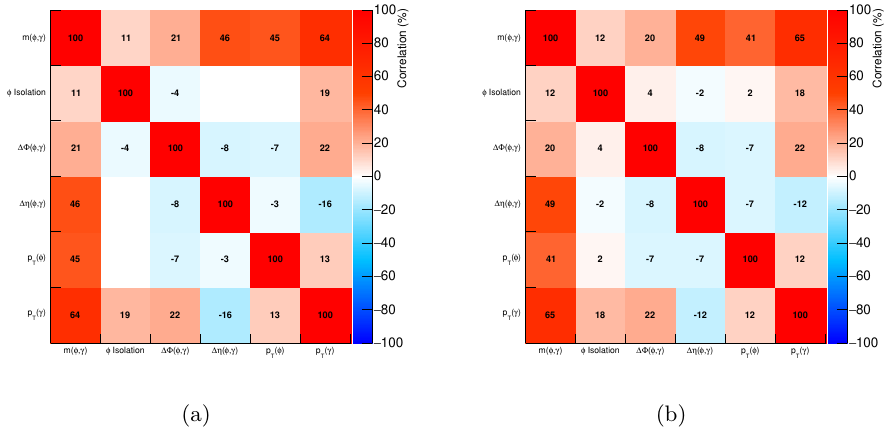
Figure 4 . Linear correlation coefficients for pairs of variables used in the background modelling procedure, shown for the simulated data events (left) and generated pseudo-candidates (right) passing the GR